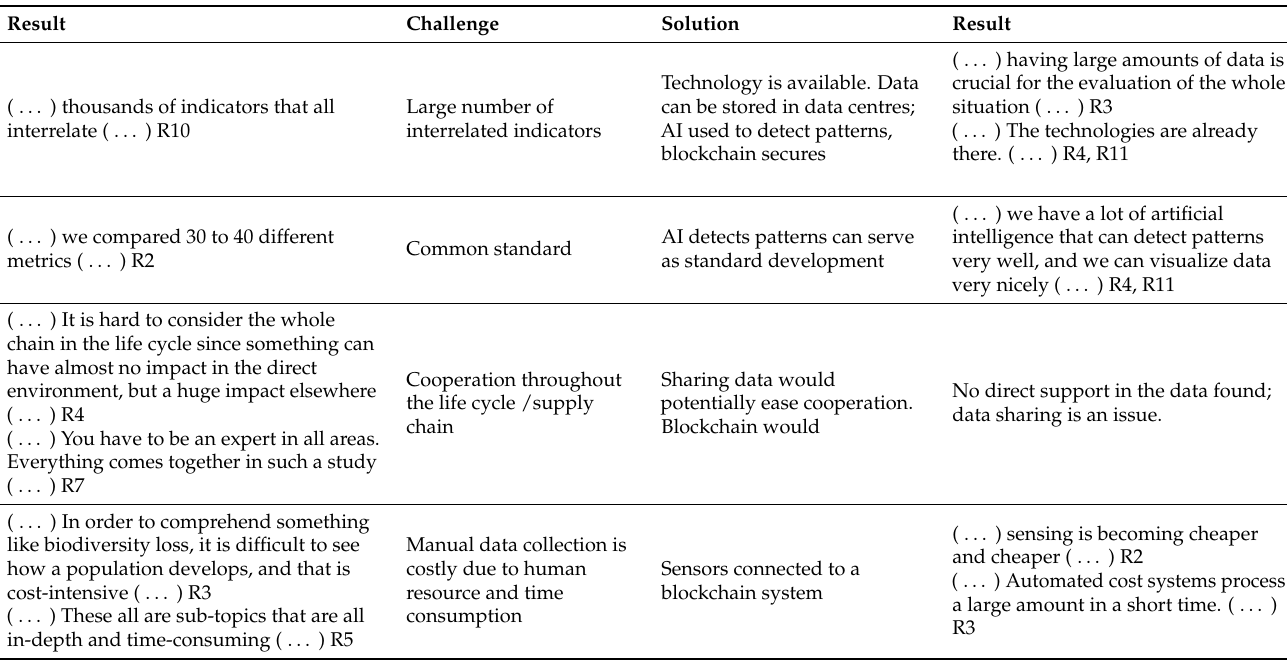
Table 3. TCA complexity and solutions.